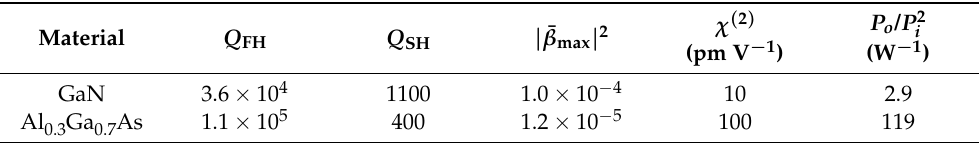
Table 3. Calculated nonlinear figures of merit for both the GaN and Al 0.3 Ga 0.7 As doubly-resonant PhC cavities designed in this